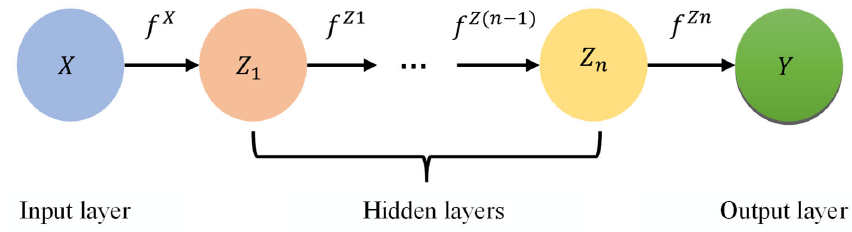
8 of 22 Table 3. The set for training rotation error prediction model. Sample Point (cid:4666)∆𝒇 𝒂 , ∆𝑭 𝒓 , ∆𝑪 𝒌 , ∆𝒓 𝒓𝒑 , ∆𝒓 𝒑 , 𝝈 , 𝒓 𝒑 , 𝒓 𝒓𝒑 , 𝜹𝑱 , 𝜹𝒕 , 𝒂 , ∆𝒓 , 𝑬𝒉 , ∆𝑭𝒂 , ∆ 𝟐 ) Rotation Error/’ 1